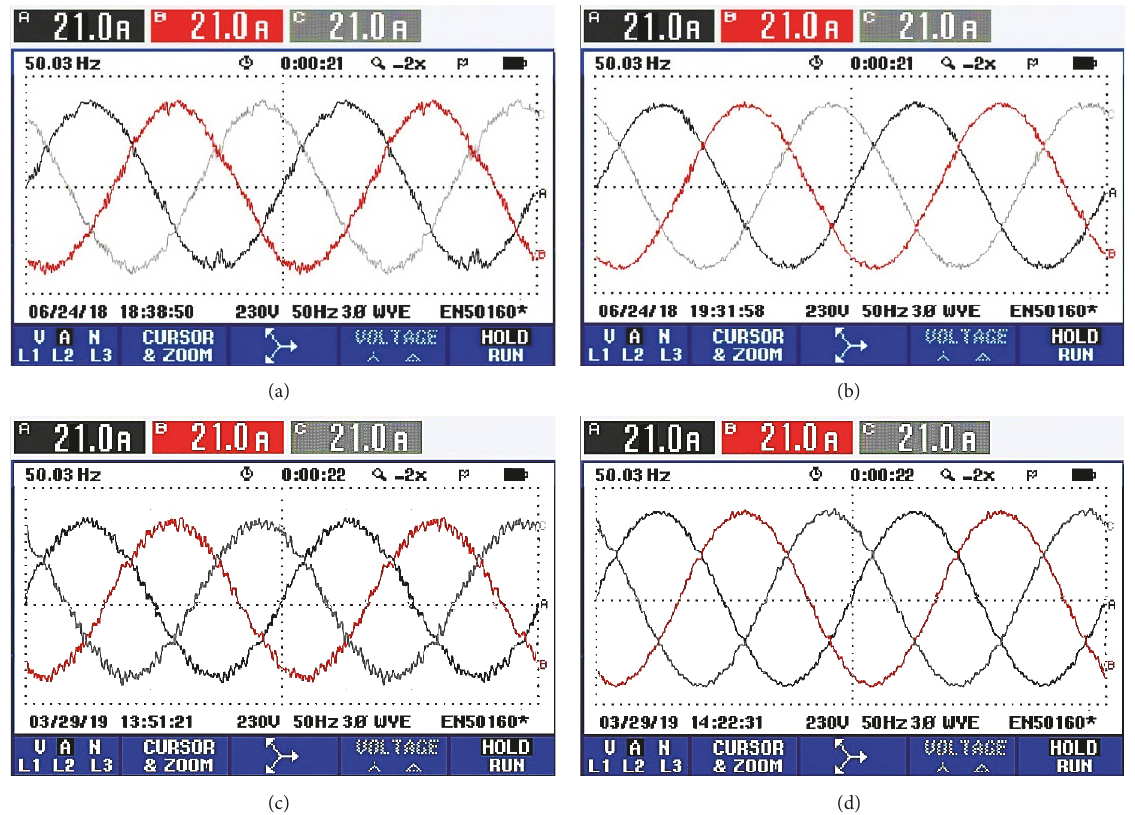
Figure 15: Waveform of three-phase grid current: (a) the Conventional MPVC, (b) the proposed MPVC, (c) the conventional MPCC, and (d) the proposed